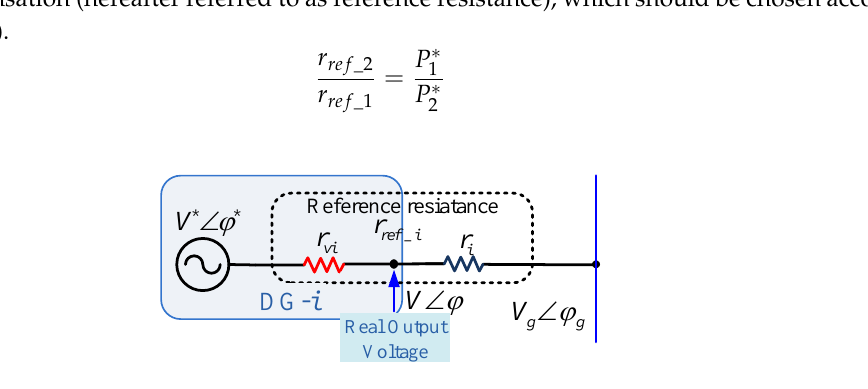
Figure 4. Equivalent output voltage source considering virtual resistance.